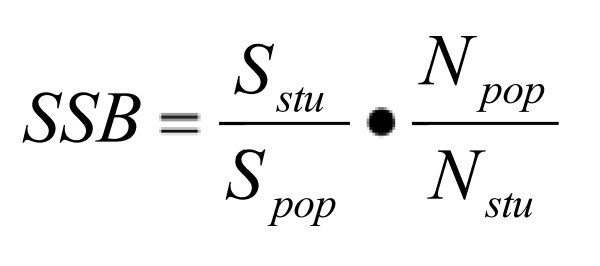
Assessment of self-selection bias. SSB self-selection bias; Sstu, Spop: self-reported Syphilis diagnoses in the last 12 months in the study (stu)/Syphilis cases attributed to MSM in the primary surveillance data (pop); Nstu, Npop: Number of MSM in the study (stu)/in the German population (pop), the latter based on extrapolations from sexual behaviour surveys of the general population.